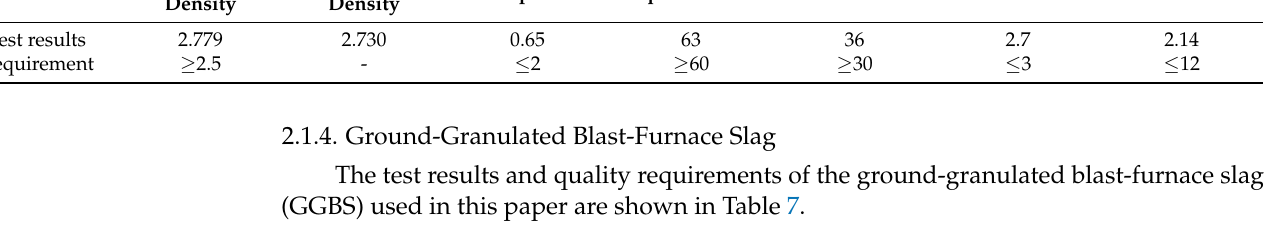
Table 7. Test results of mineral